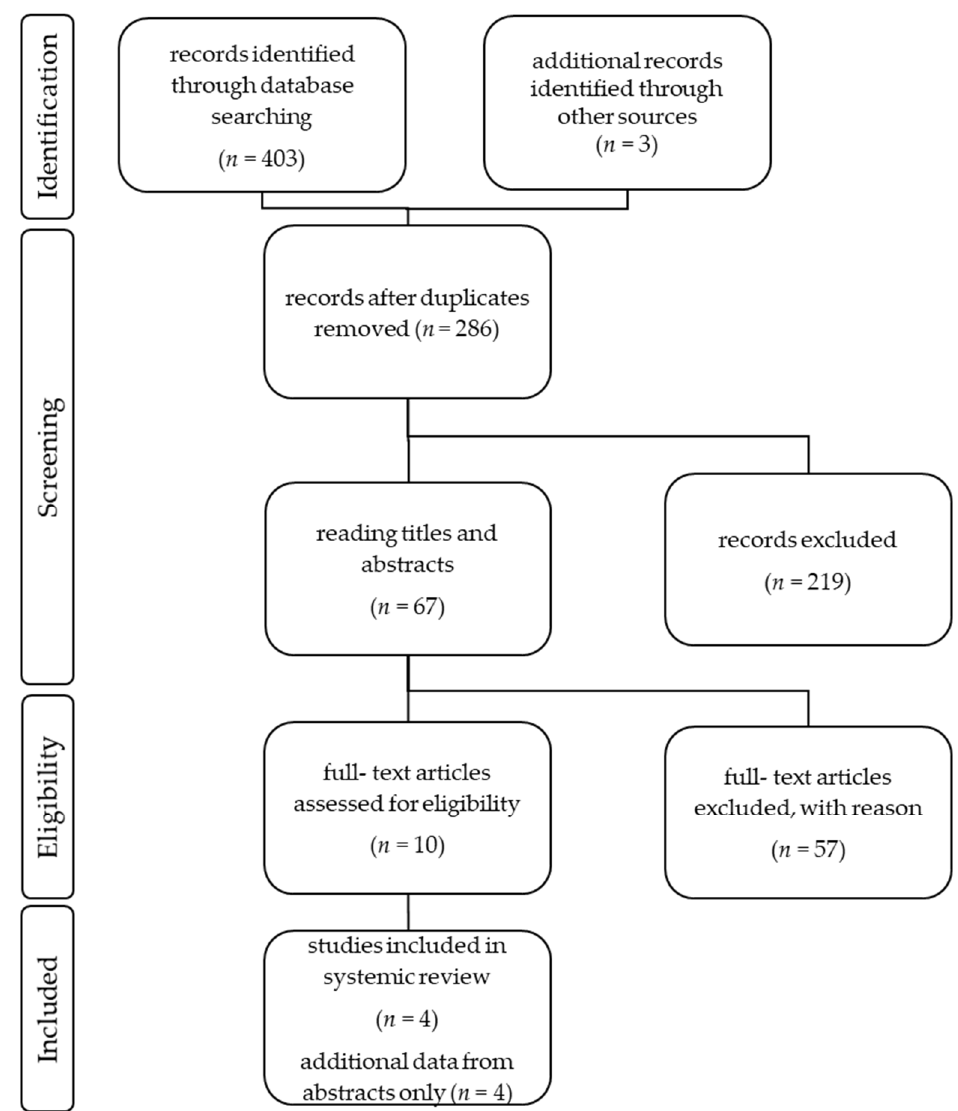
Figure 2. An overview of the study selection following the recommendations of the PRISMA state-